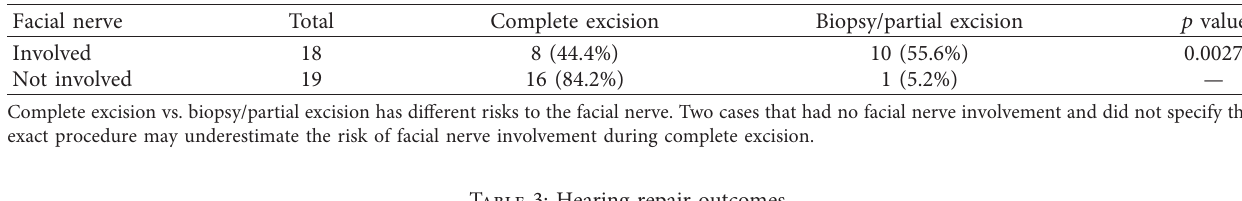
Table 2: Facial nerve involvement.